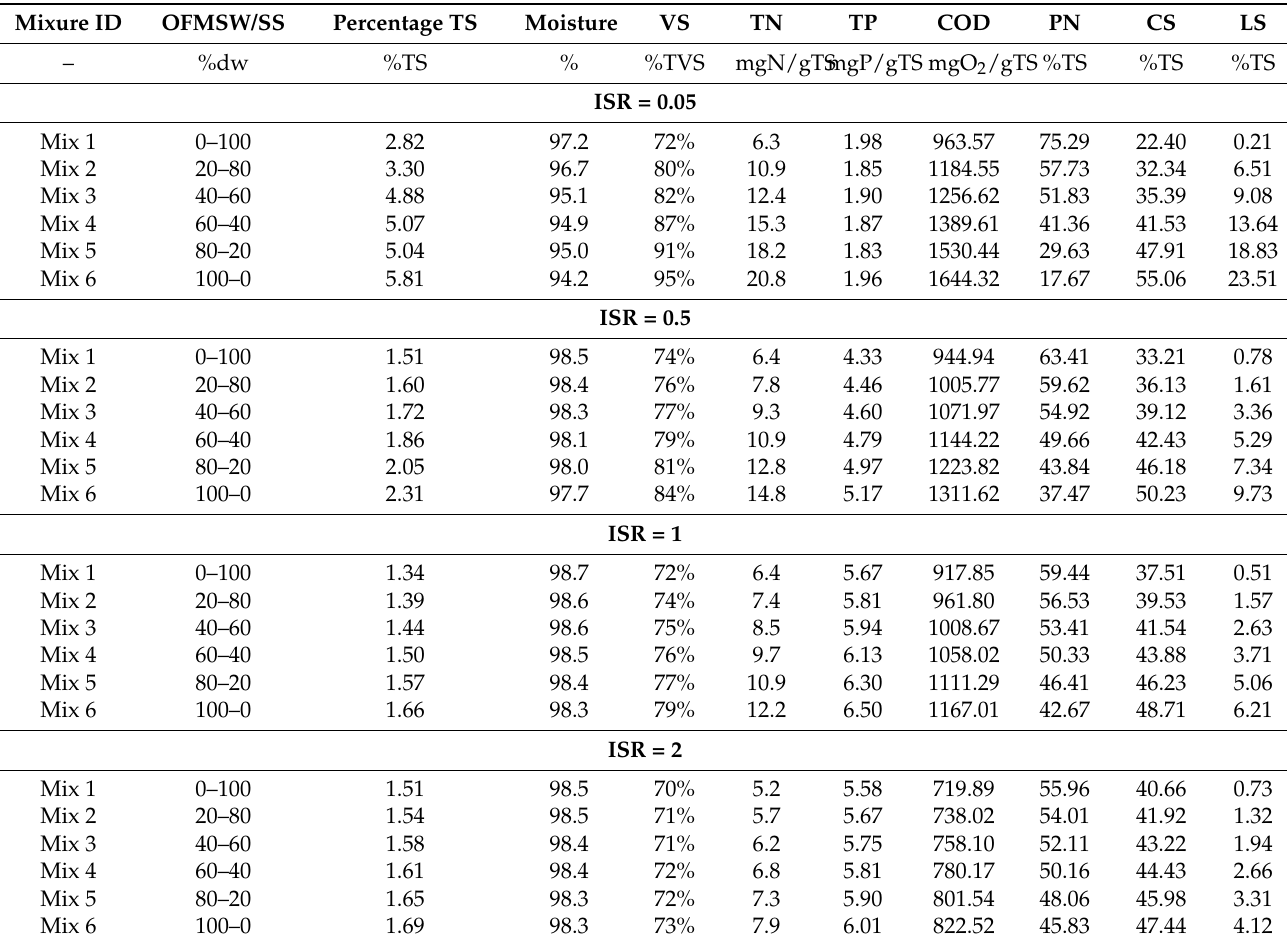
Table 1. Ratio of mixtures and composition for BMP.